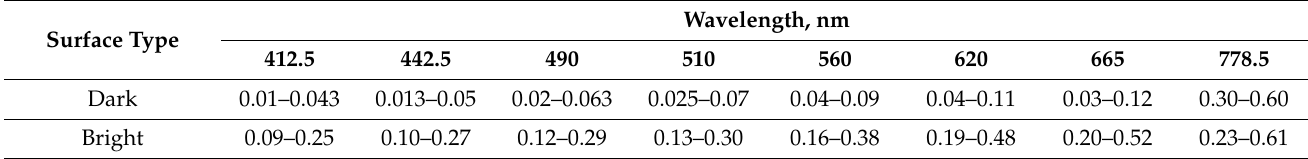
Table 2. Reflectance ranges of dark and bright surfaces in the MS spectral channels.